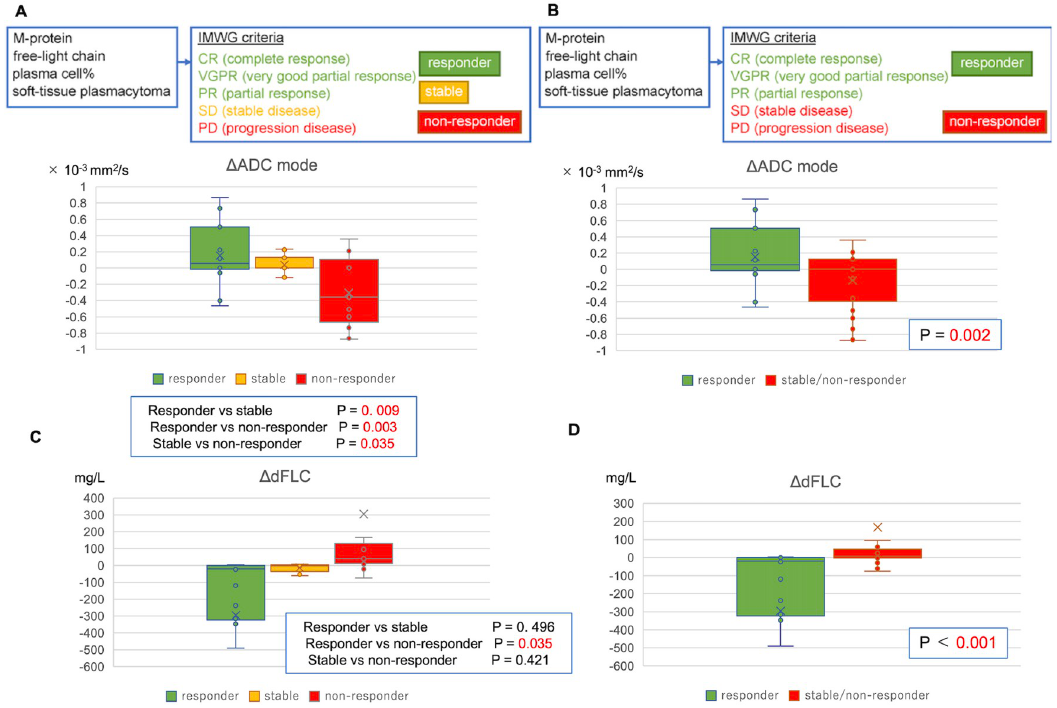
Fig 5. Treatment effectiveness and apparent diffusion coefficient (ADC) values. (A) Comparison between the responder (partial response or better, N = 13, ADC mode : 0.154 ± 0.386 × 10 − 3 mm 2 /s), stable (stable disease, N = 12, ADC mode : 0.038 ± 0.111 × 10 − 3 mm 2 / s), and non-responder (progressive disease, N = 13, ADC mode : -0.307 ± 0.424 × 10 − 3 mm 2 /s) groups. (B) Comparison between the responder (N = 13, ADC mode : 0.154 ± 0.386 × 10 − 3 mm 2 /s) and non-responder + stable (N = 25, ADC mode : -0.135 ± 0.351 × 10 − 3 mm 2 /s) groups. Δ ADC mode was significantly higher in the responder group than that in the stable + non-responder group. (C) Average dFLC in the responder (-294.98 ± 677 mg/L), stable (-13.11 ± 25.11 mg/L) and non-responder (305.87 ± 715.10 mg/L) groups increased with a worsening in disease prognosis, albeit no significant difference was observed. (D) dFLC differed significantly between the responder (-294.98 ± 677 mg/L) and non-responder + stable (167.18 ± 552 mg/L) groups. dFLC, difference free-light chain; IMWG, International Myeloma Work